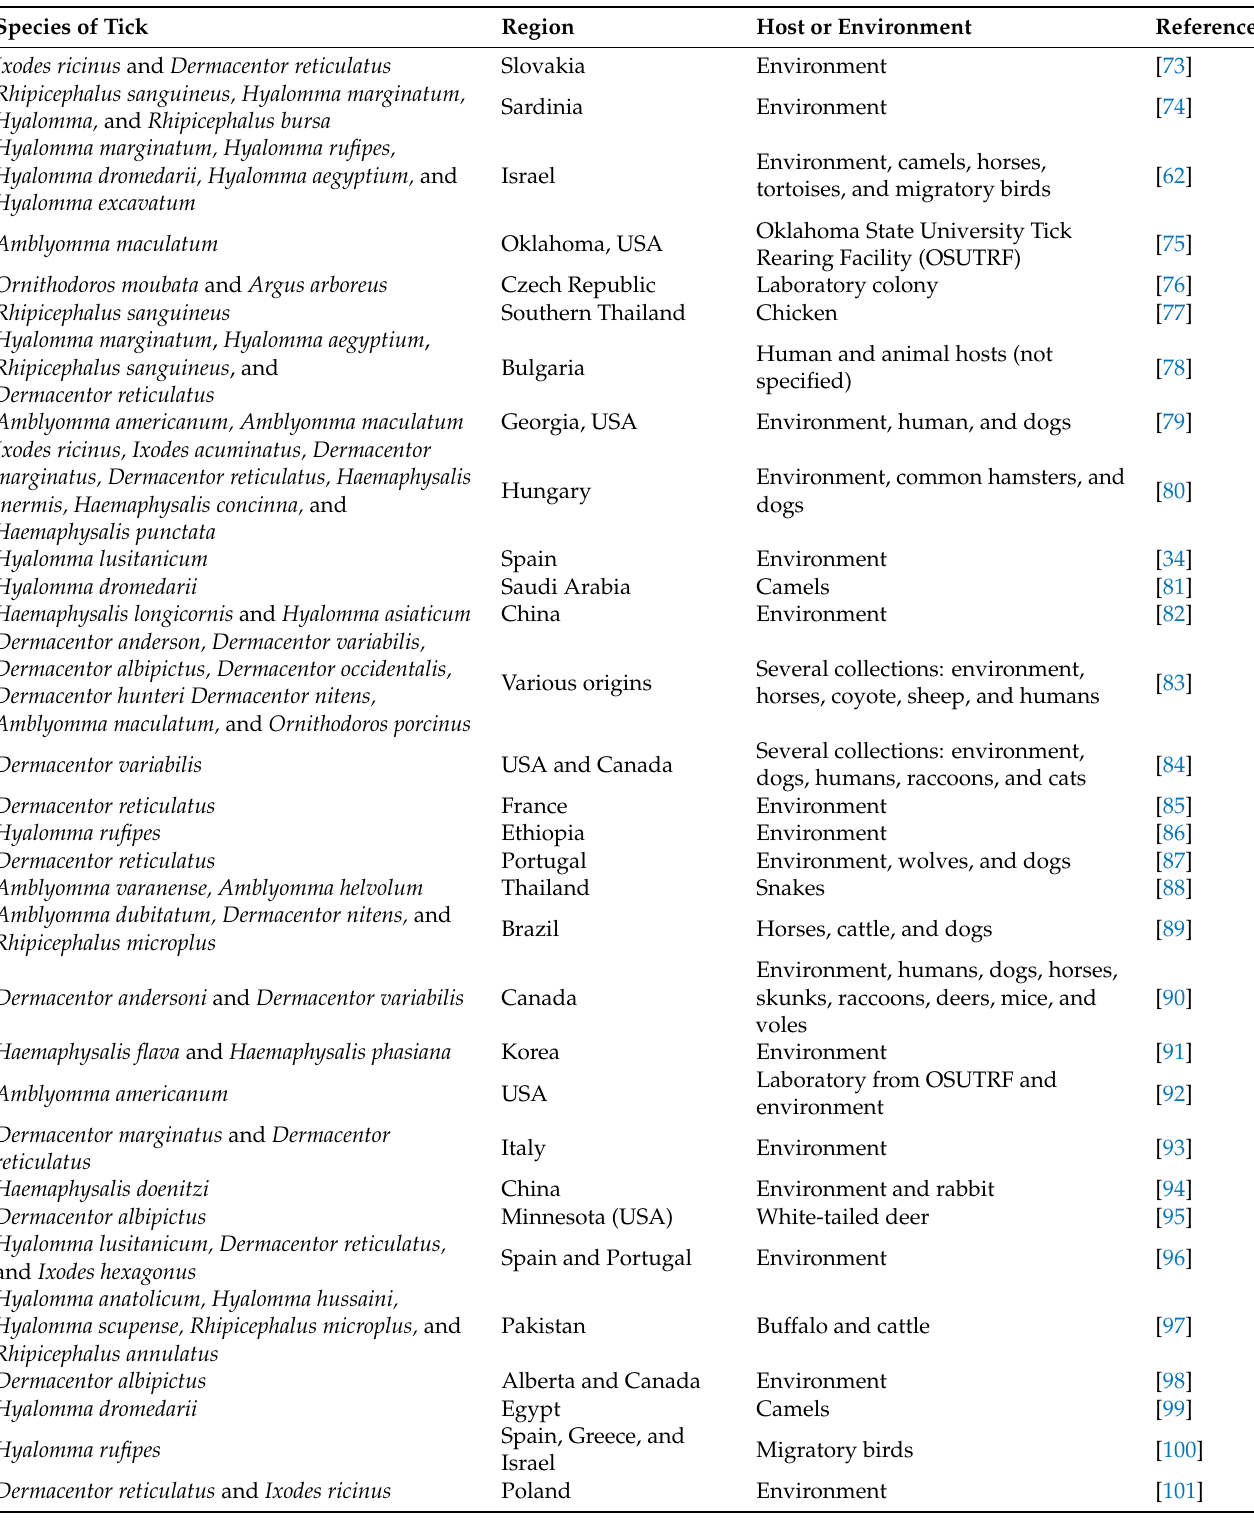
Table 2. Current evidence of Francisella- like endosymbionts in ticks and their